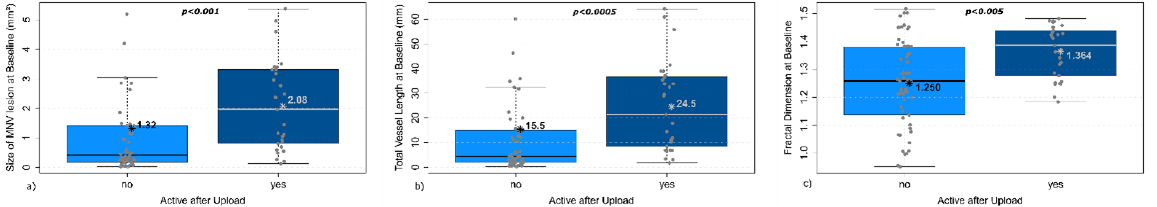
Figure 2. Boxplots showing the distribution of the area ( a ), total vascular length ( b ), and fractal dimension ( c ) of the MNV at the time of initial diagnosis in relation to the activity status after three intravitreal injections of anti-VEGF. Each dot represents an individual measurement. The boxes enclose the measurements between the uppermost and lowermost quartiles. The whiskers show the last measurements within the 1.5-fold interquartile range. * = Mean, bar = median; Wilcoxon rank-sum test.